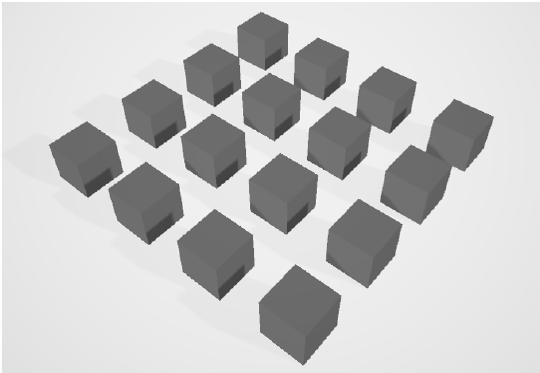
Figure 3. Idealized city model with 4 × 4